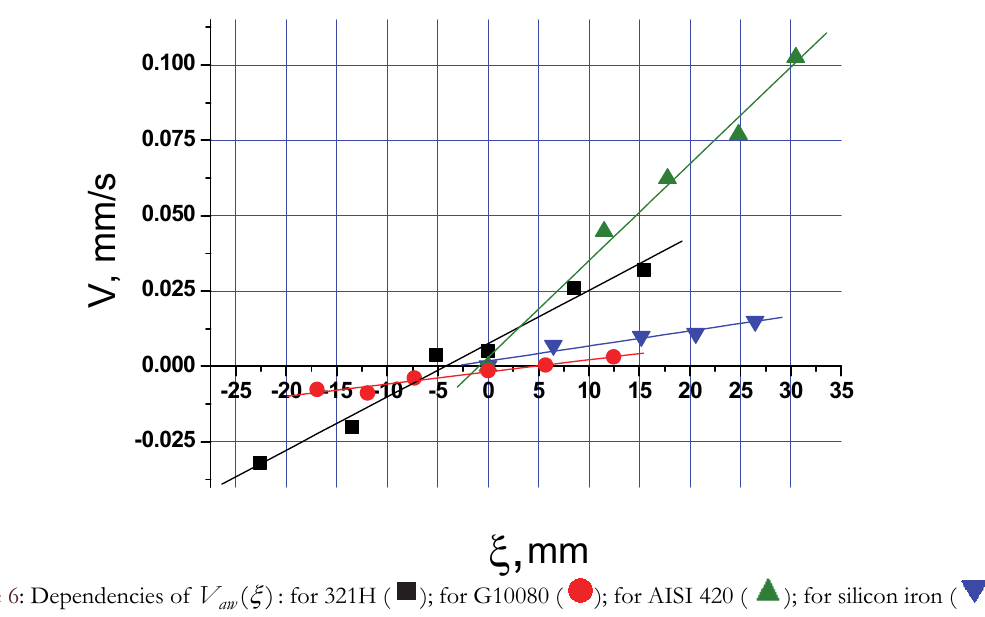
V  : for 321H ( ); for G10080 ( ); for AISI 420 ( ); for silicon iron ( Figure 6: Dependencies of ( ) aw